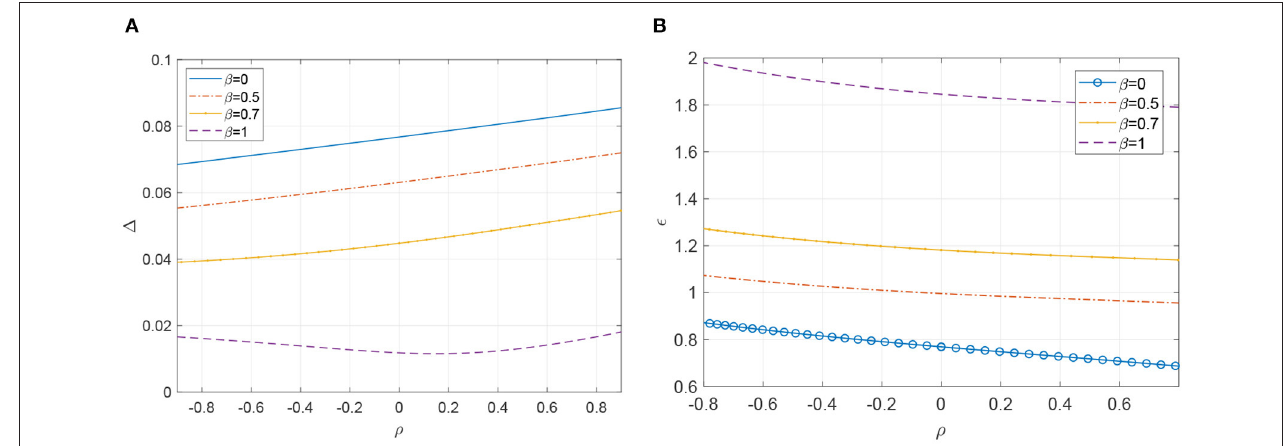
FIGURE 5 | (A) Hopf bifurcation curves of the fixed point of (19). A stable periodic orbit exists below the curve. Other parameters: ǫ 0.2, ω 0 1, m 100, M 400. (B) SNIC bifurcation curve ( β = = = = value of β a stable periodic orbit exists below the curve. Other parameters: 1